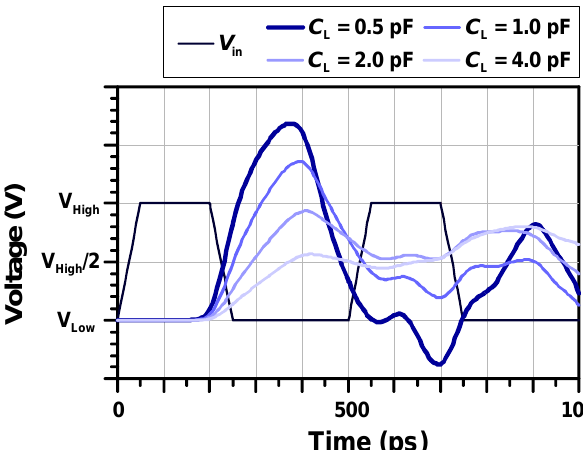
Figure 13: Transient responses versus load C L for case